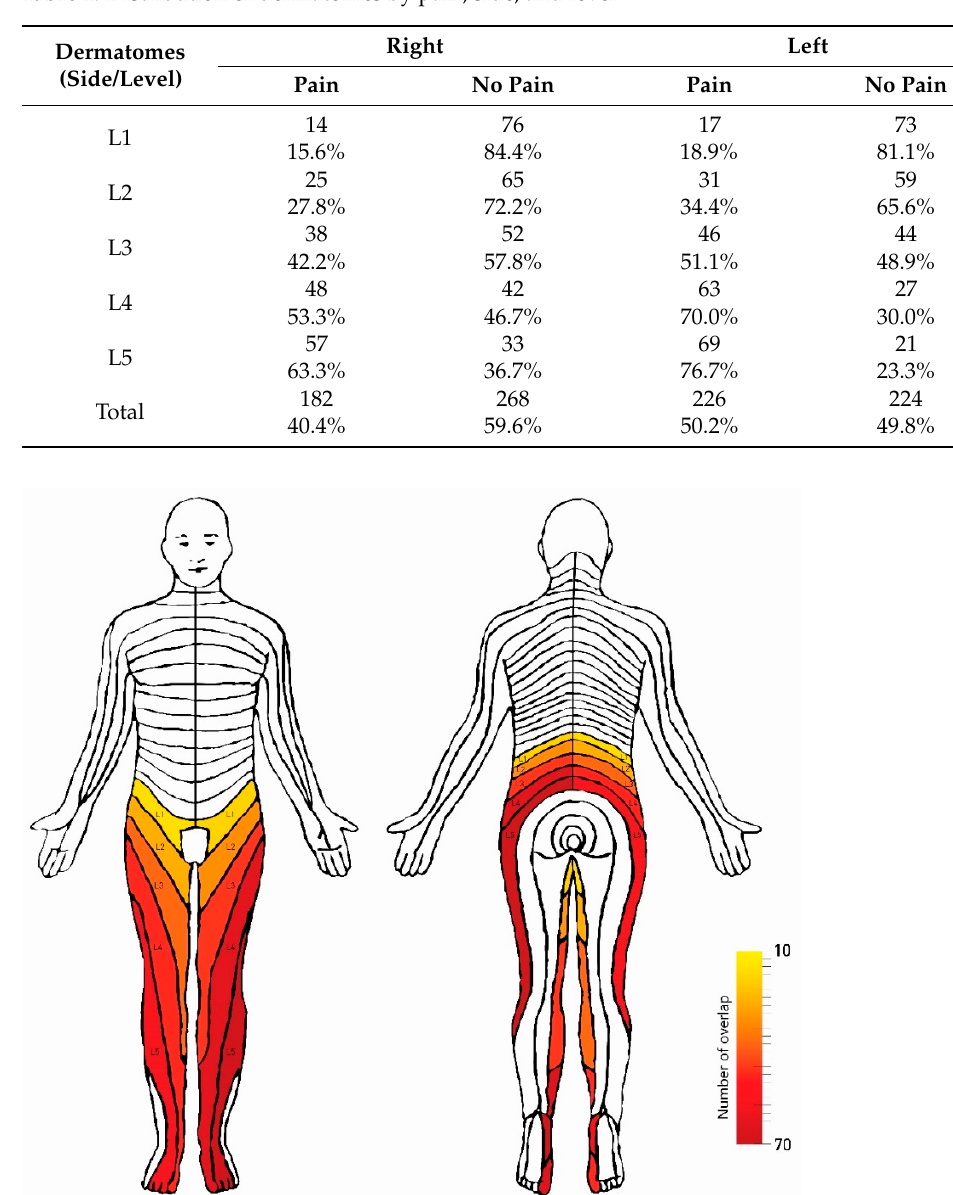
Table 1. Distribution of dermatomes by pain, side, and level.